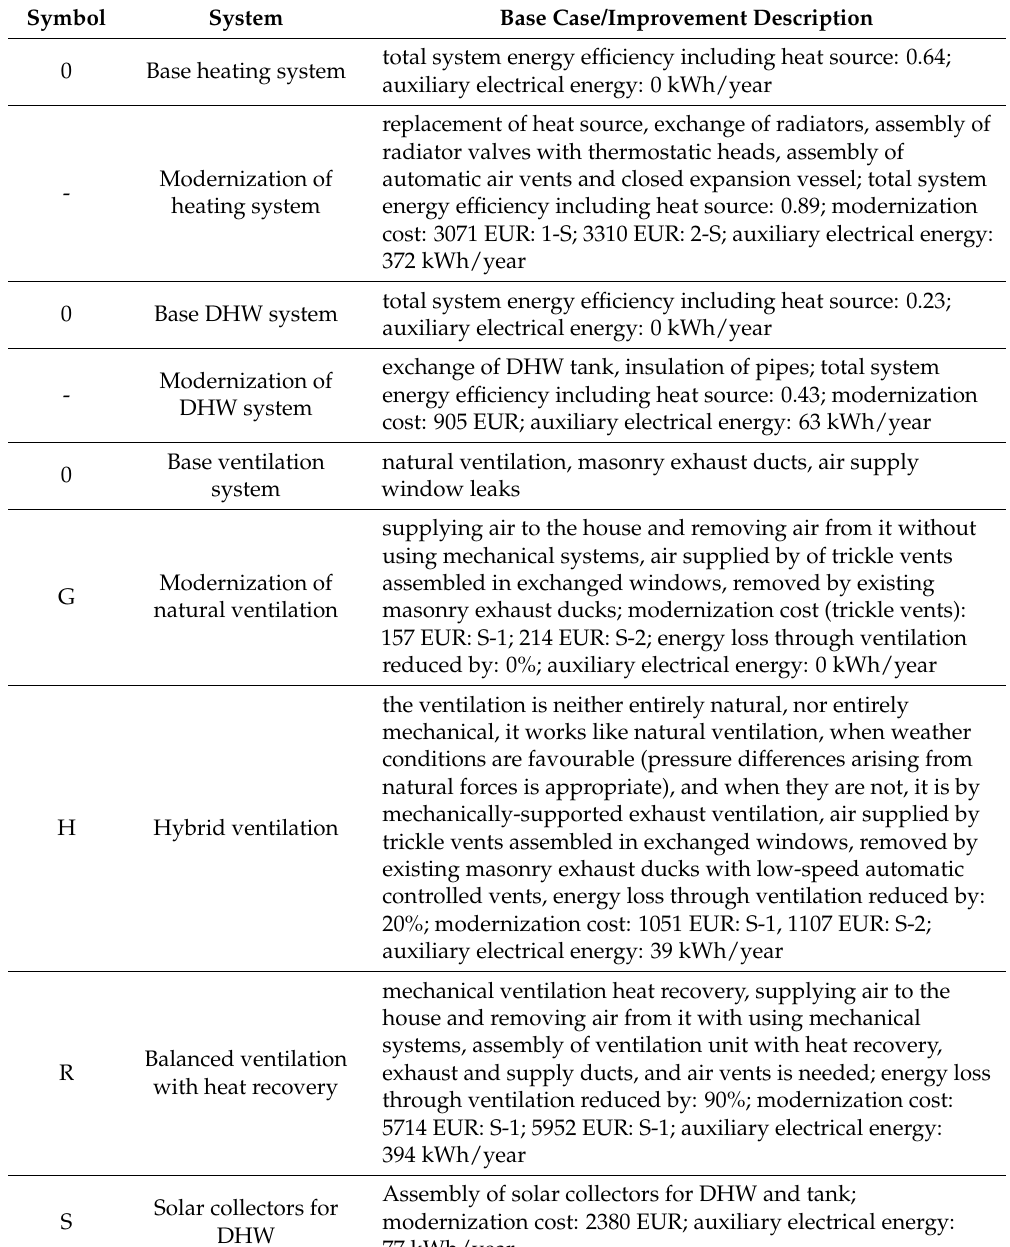
Table 15. Description of base case solutions and improvements of heating, DHW and ventilation